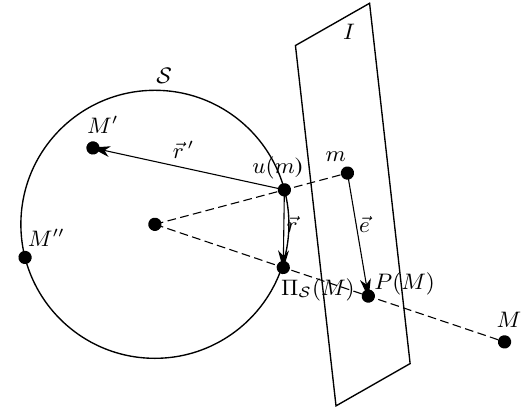
Figure 2. Sphere-based incidence function Π S ( M ) − u ( m ) between an image point m and an object point that is either outside ( M ) or inside ( M (cid:48) ) the unit sphere. Case of a non-visible stationary point ( M (cid:48)(cid:48) ). Comparison of the 3D incidence residual vectors (cid:126)r and (cid:126)r (cid:48) with the 2D reprojection error (cid:126)e = P ( M ) − m